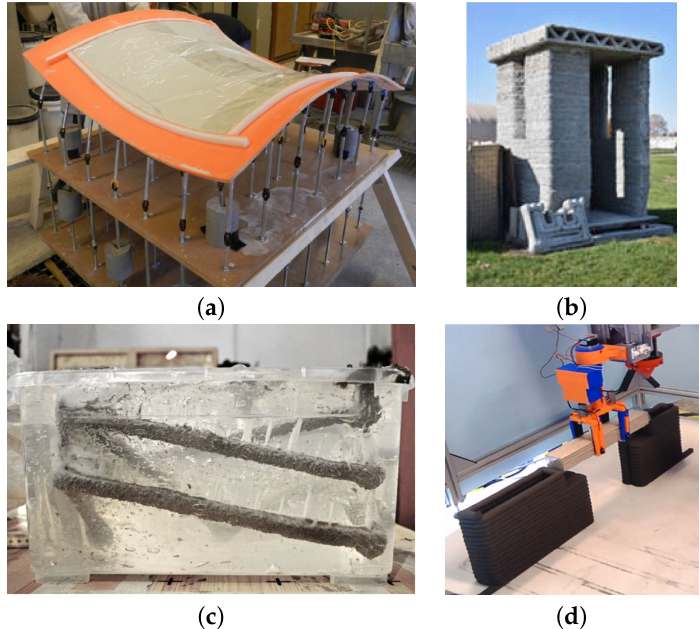
Figure 1. ( a ) Flexible Mould [5], ( b ) Entry Control Point [11], ( c ) material injected into a gel [28], ( d ) use of a gripper for lintel placement